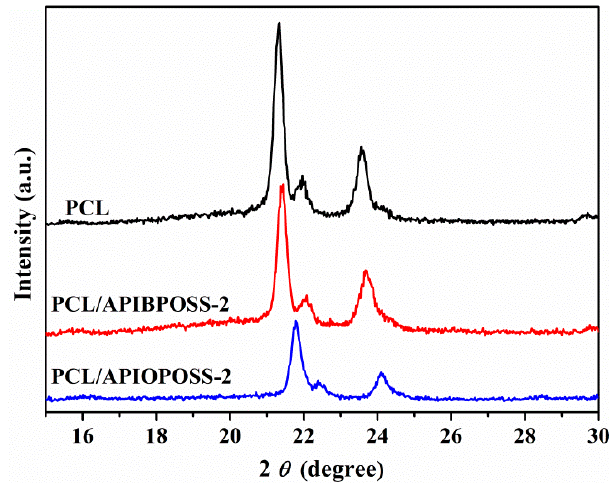
Figure 14. XRD patterns of neat PCL and PCL/POSS nanocomposites.